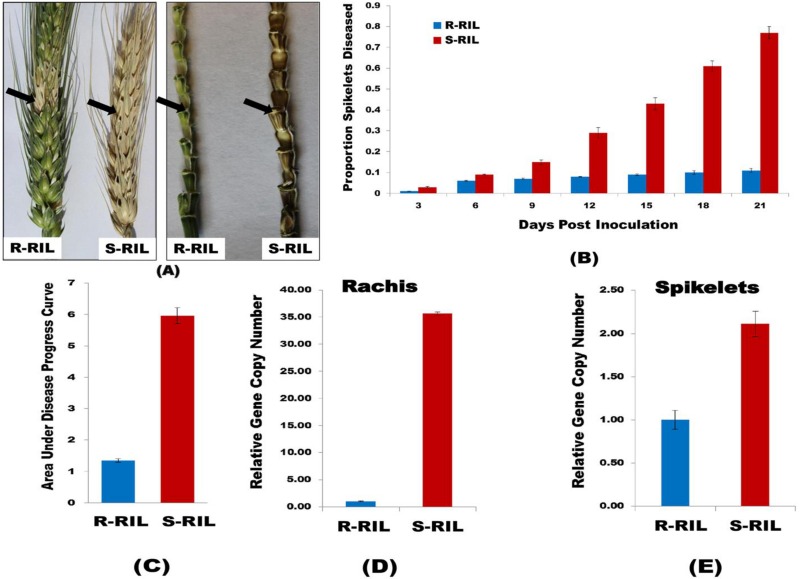
Phenotyping of RILs.(A). Spike and rachis of R-RIL and S-RIL, 21 dpi with F. graminearum spore suspension. A single alternate pair of spikelets in a spike was inoculated; black arrows indicate the site of inoculation. The spike and rachis in R-RIL shows only necrotic spots or diseased symptoms limited to the inoculated spikelet, while in S-RIL both spikelet and rachis are entirely diseased. (B). Proportion of Spikelets Diseased (PSD). A single pair of spikelets of a spike was inoculated in both the RILs and the proportion of spikelets diseased was recorded at 3 days intervals until 21 days, from which the PSD was calculated. The bar graph shows high PSD in S-RIL as compared to R-RIL. (C). The bar graph shows area under disease progress curve (AUDPC) calculated from PSD, significantly higher in S-RIL. (D) and (E). Fungal Biomass quantification in RILs. Three alternate pair of spikelets were inoculated with F. graminearum spore suspension and samples were collected at 7 dpi. The total genomic DNA was extracted and the relative gene copy number of Tri6 was estimated using 2−ΔΔCT method. (D). Shows the relative gene copy number of Tri6 in rachis tissues; (E). Shows the relative gene copy number of Tri6 in spikelet tissues. In both graphs, the gene copy number of Tri6 is significantly higher in S-RIL as compared to R-RIL.